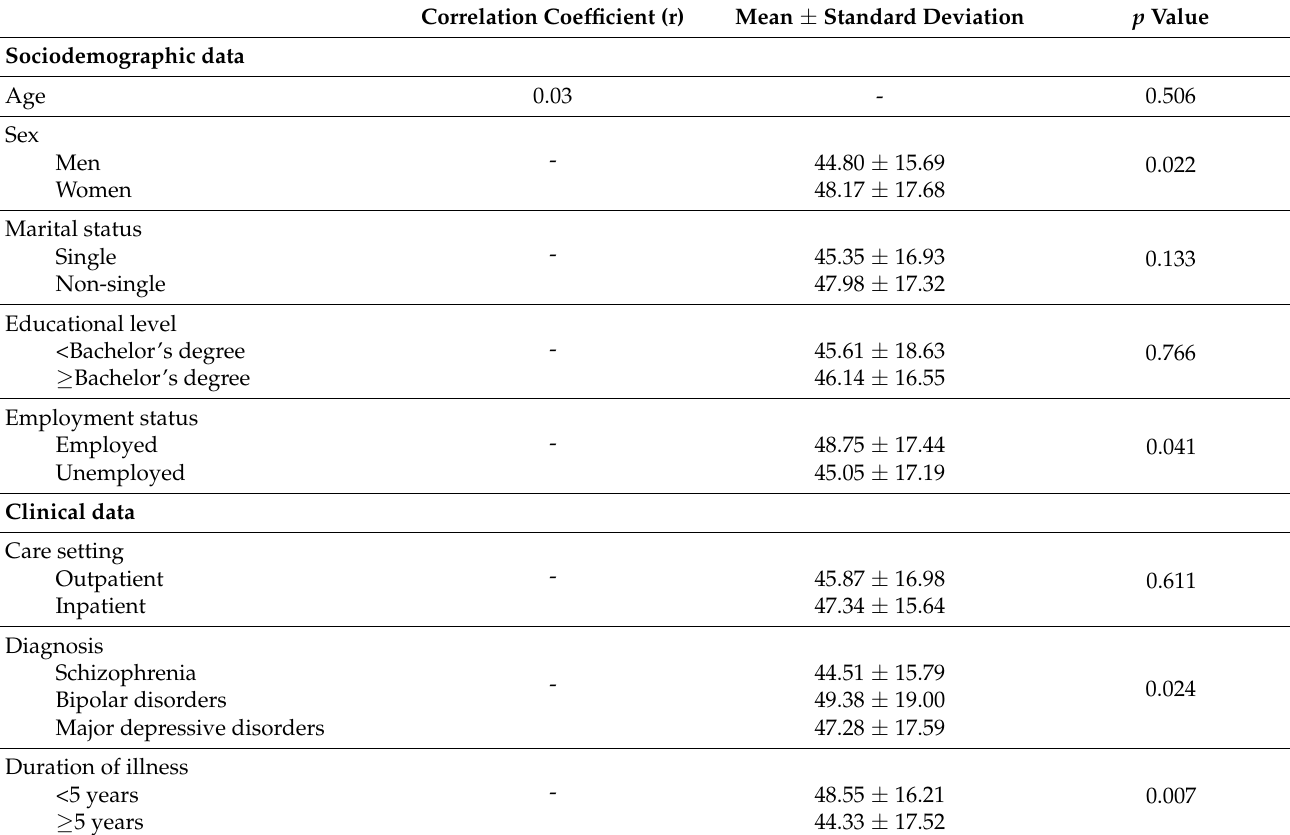
Table 3. Comparison of PREMIUM-DT scores with sociodemographic and clinical data and proxy measures of quality of